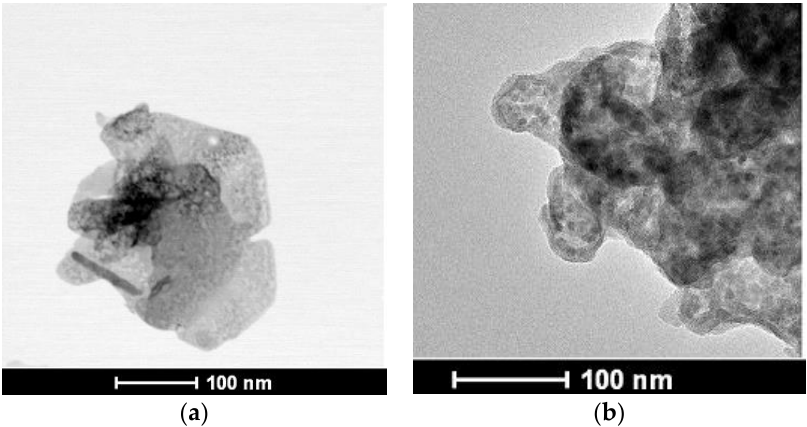
Figure 12. TEM images of the materials after Mo(VI) adsorption: ( a ) Mg 4 Fe and ( b ) Mg 4 Fe-450.